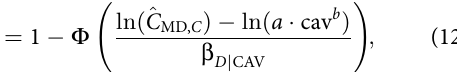
Frontiers in Built Environment |